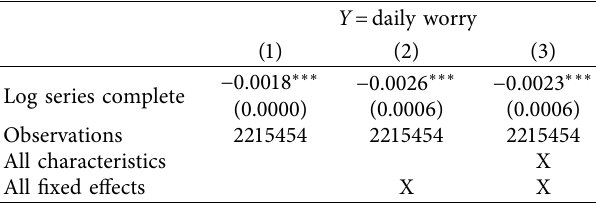
Table 3: Vaccination and